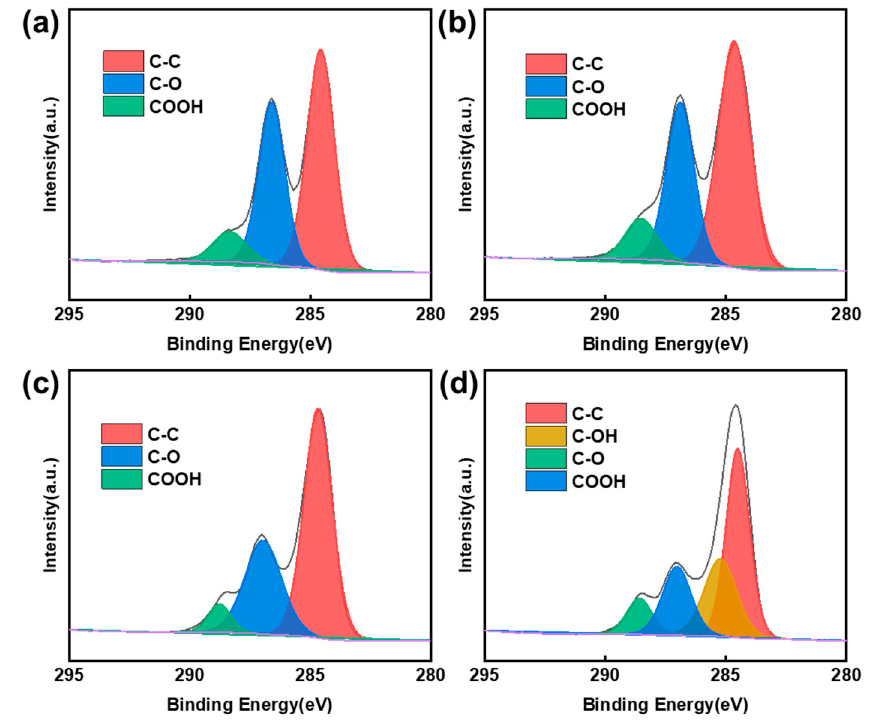
Figure 3. XPS C 1s analysis of ( a ) GO, ( b ) GO-100, ( c ) GO-110 and ( d ) GO-120.